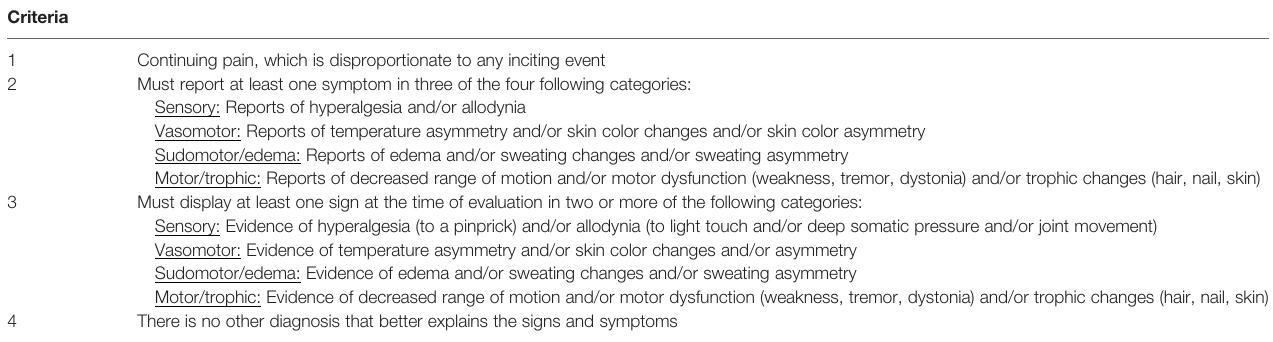
TABLE 2 | Budapest criteria for the clinical diagnosis of CRPS